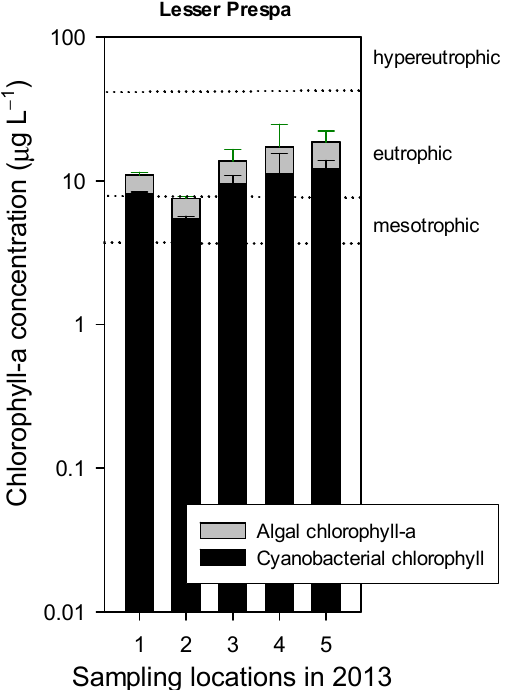
Figure 6. Mean cyanobacterial- (black bars) and eukaryotic algal (grey bars) chlorophyll-a concen- trations ( μ g L − 1 ) in samples collected on 3 September 2013 at five sites in Lake Lesser Prespa (1–5). The different dotted lines indicate boundaries in trophic state based on chlorophyll-a concentra- tions [42,43].